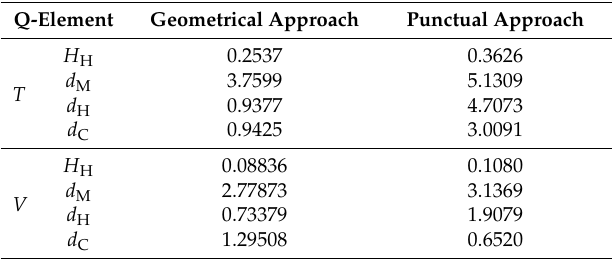
Table 6. Geometrical and punctual model MRE comparison.